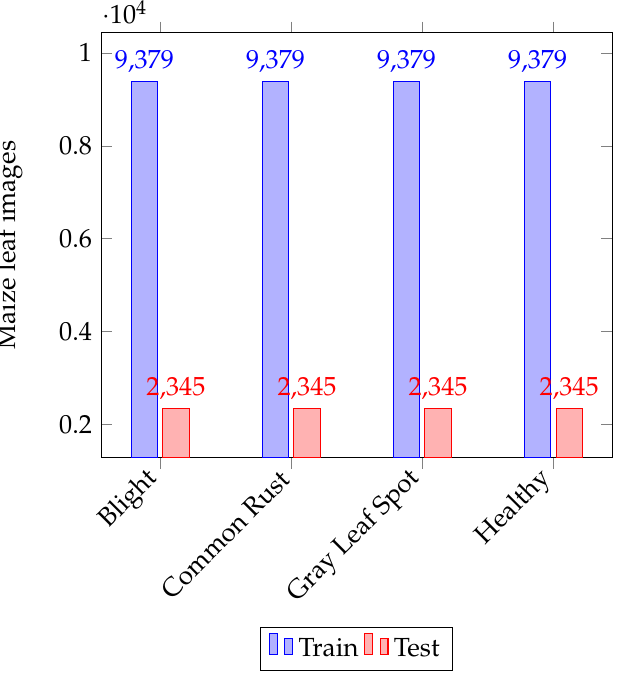
Figure 3. Training and test image distribution. The final dataset for maize leaf disease classification and quantification contains 9379 training images of each class and 2345 test images of each class. This represents an 80–20% train–test split. In total, there are 46,898 images in our augmented PlantVillage maize leaf disease